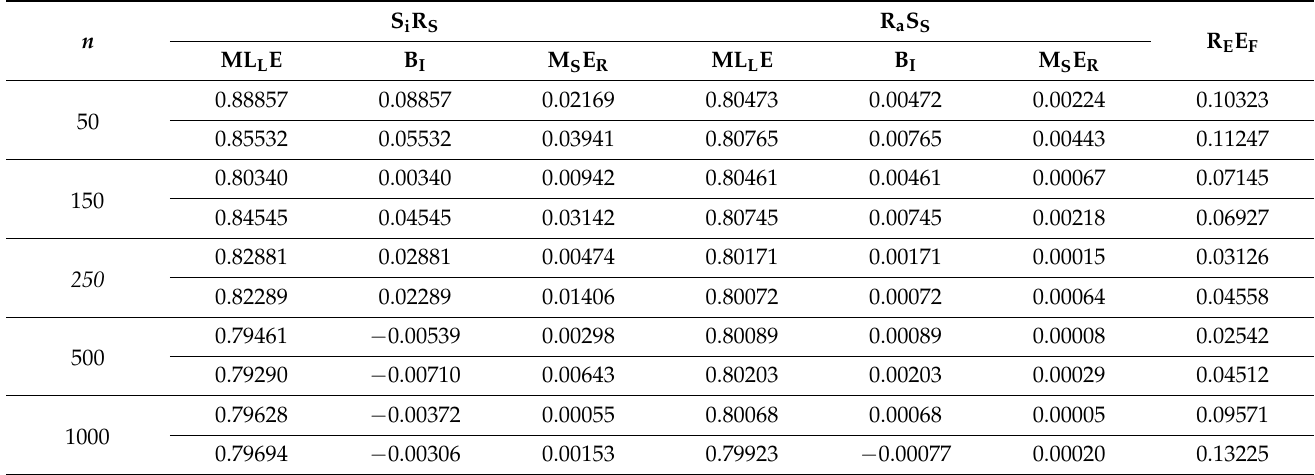
Table 6. The ML L E s , B I s, M S E R , and R E E F of the KMB X model under S i R S and R a S S at α = 0.8, β =